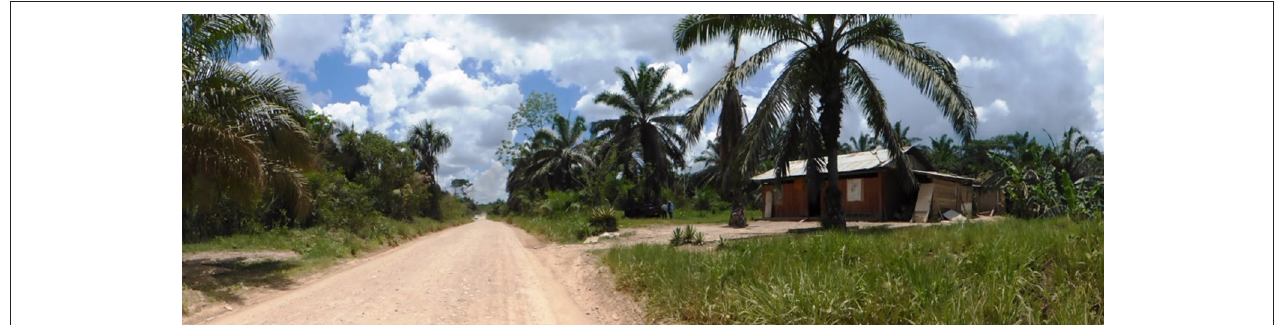
FIGURE 1 | Photograph of Pueblo Libre village, Ucayali, Peru. Source: Photograph taken by G. S. Cruz-Garcia.